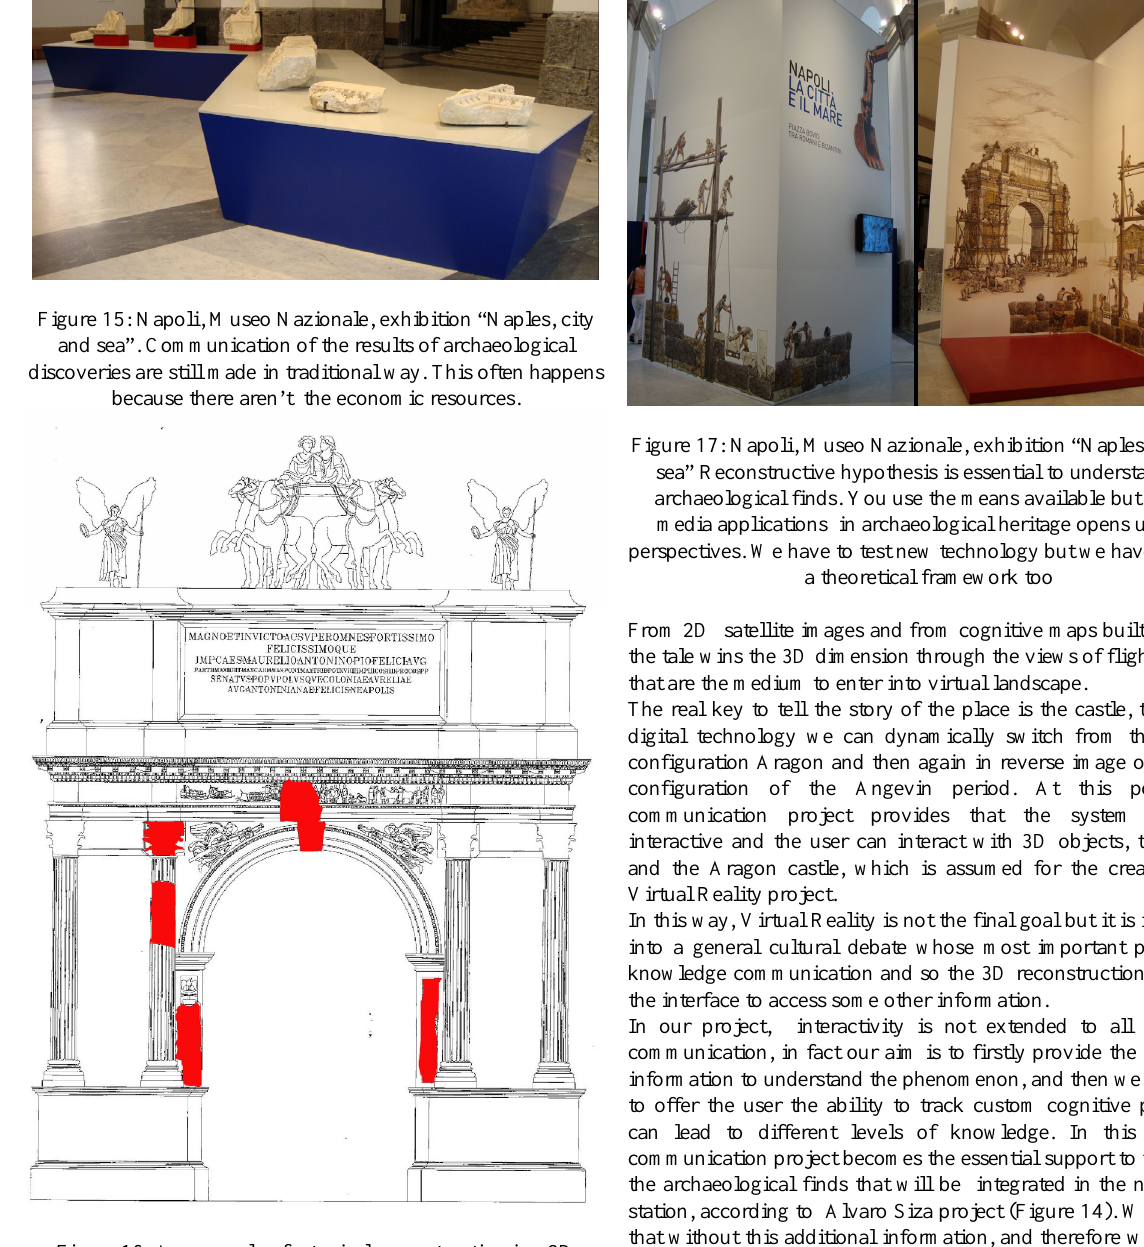
Figure 16: An example of a typical reconstruction is a 2D drawing in which the finds are collocated